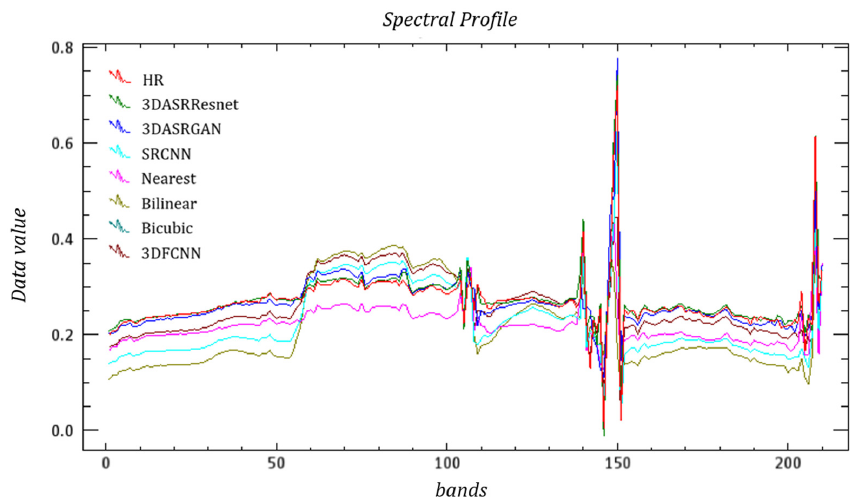
Figure 12. Example Spectral Curves of Grass based on the Urban dataset. Remote Sens. 2019 , 11 , x FOR PEER REVIEW